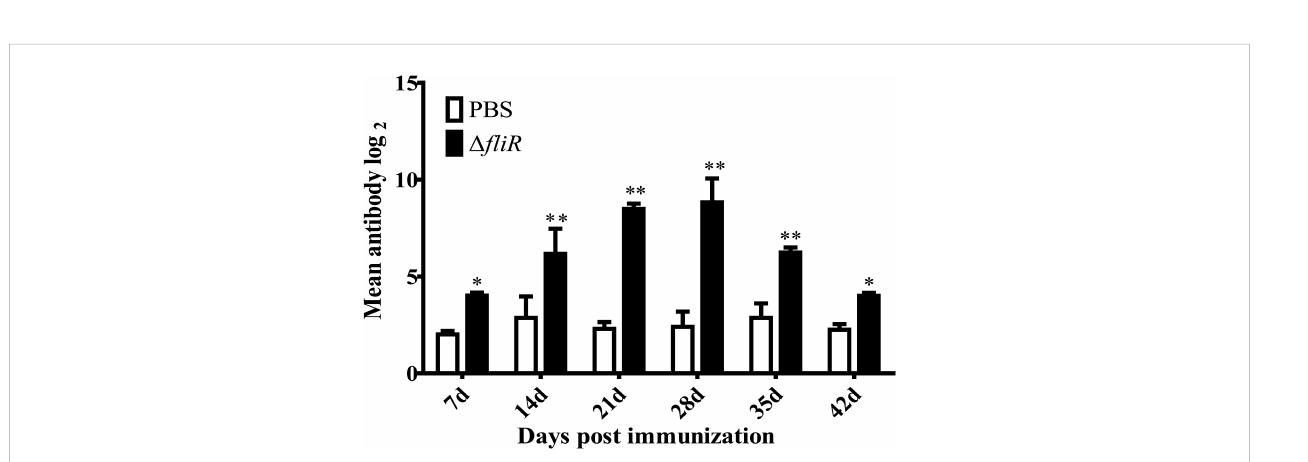
FIGURE 6 Determination of speci fi c antibody titers following immunization of grouper with the fl iR mutant strain. ELISA analyzed the IgM antibody titers in experimental fi sh 1-6 weeks after administration of the mutant strain. A consistent increase in serum antibody titers was seen in the experimental group from days 1-28, reaching a peak level on day 28, with a subsequent decrease. *indicate signi fi cant differences (p<0.05), **indicate extremely signi fi cant differences (p<0.01).